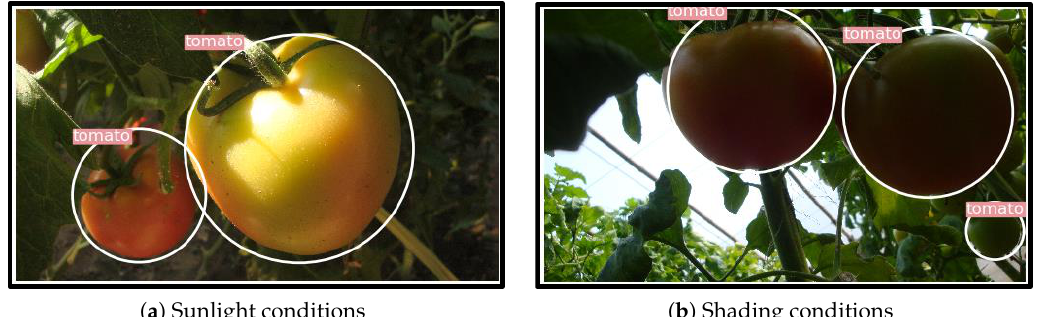
Figure 14. Some examples of the detection results under different lighting conditions.